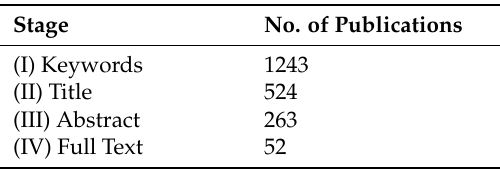
Table 6. Examined Publications per